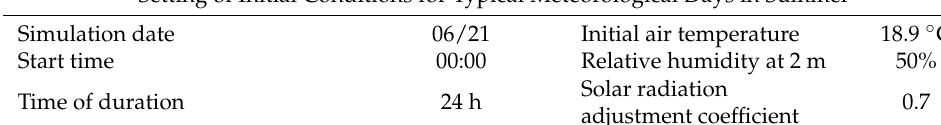
Table 6. Simulation time and boundary Table 6. Simulation time and boundary conditions. Table 6. Simulation time and boundary conditions. Table 6. Simulation time and boundary conditions. Table 6. Simulation time and boundary conditions. Table 6. Simulation time and boundary conditions. Table 6. Simulation time and boundary conditions. Table 6. Simulation time and boundary conditions. Table 6. Simulation time and boundary conditions. Table 6. Simulation time and boundary conditions. Table 6. Simulation time and boundary conditions. Table 6. Simulation time and boundary conditions. Table 6. Simulation time and boundary conditions. Table 6. Simulation time and boundary conditions. Table 6. Simulation time and boundary conditions. Table 6. Simulation time and boundary conditions. Table 6. Simulation time and boundary conditions. Table 6. Simulation time and boundary conditions. Table 6. Simulation time and boundary conditions. Table 6. Simulation time and boundary conditions. Table 6. Simulation time and boundary conditions. Table 6. Simulation time and boundary conditions. Table 6. Simulation time and boundary conditions. Table 6. Simulation time and boundary conditions. Table 6. Simulation time and boundary conditions. Table 6. Simulation time and boundary conditions. Table 6. Simulation time and boundary conditions. Table 6. Simulation time and boundary conditions.